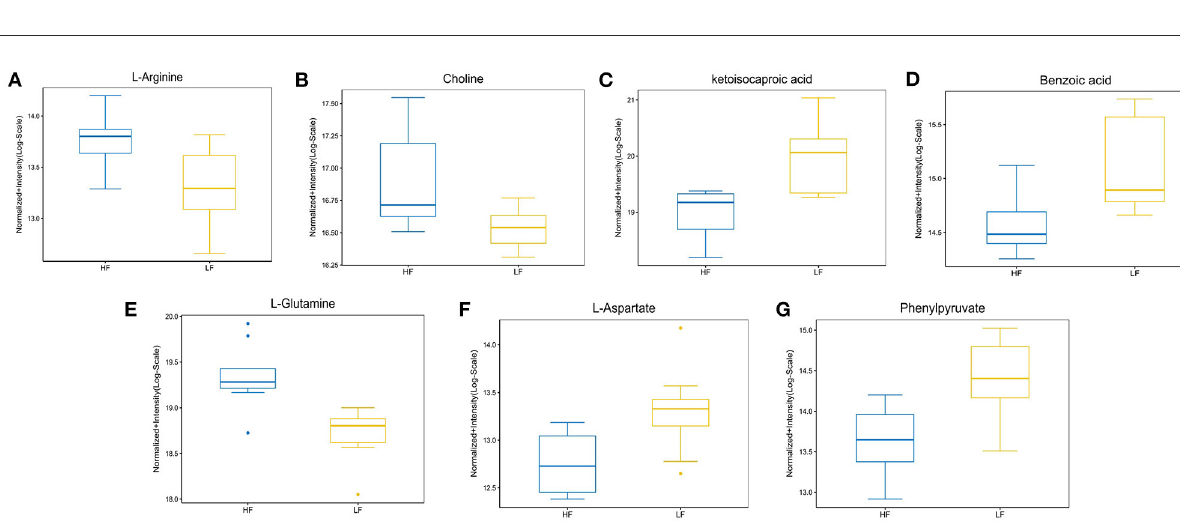
FIGURE5 The abundance ratio of important metabolites in HF and LF goat seminal plasma. (A) L-arginine, (B) choline, (C) ketoisocaproic acid, (D) benzoic acid, (E) L-glutamine, (F) L-aspartate, and (G) phenylpyruvate showed significantly different abundance between HF and LF goat seminal